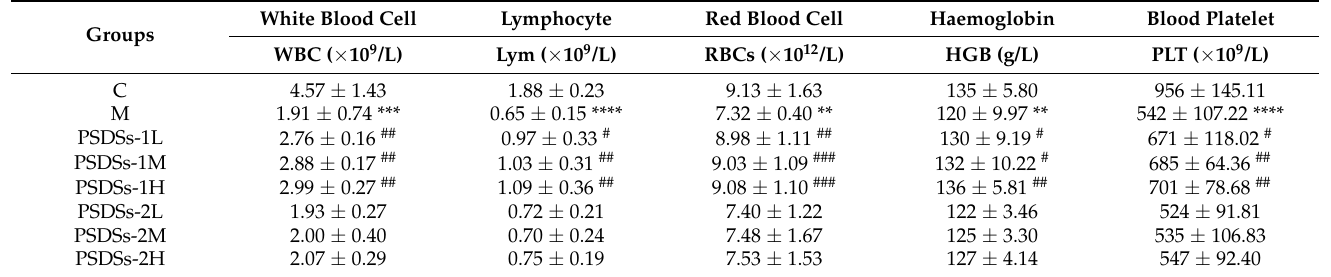
Table 1. The effect of PSDSs with different Mw on routine hematological parameters in